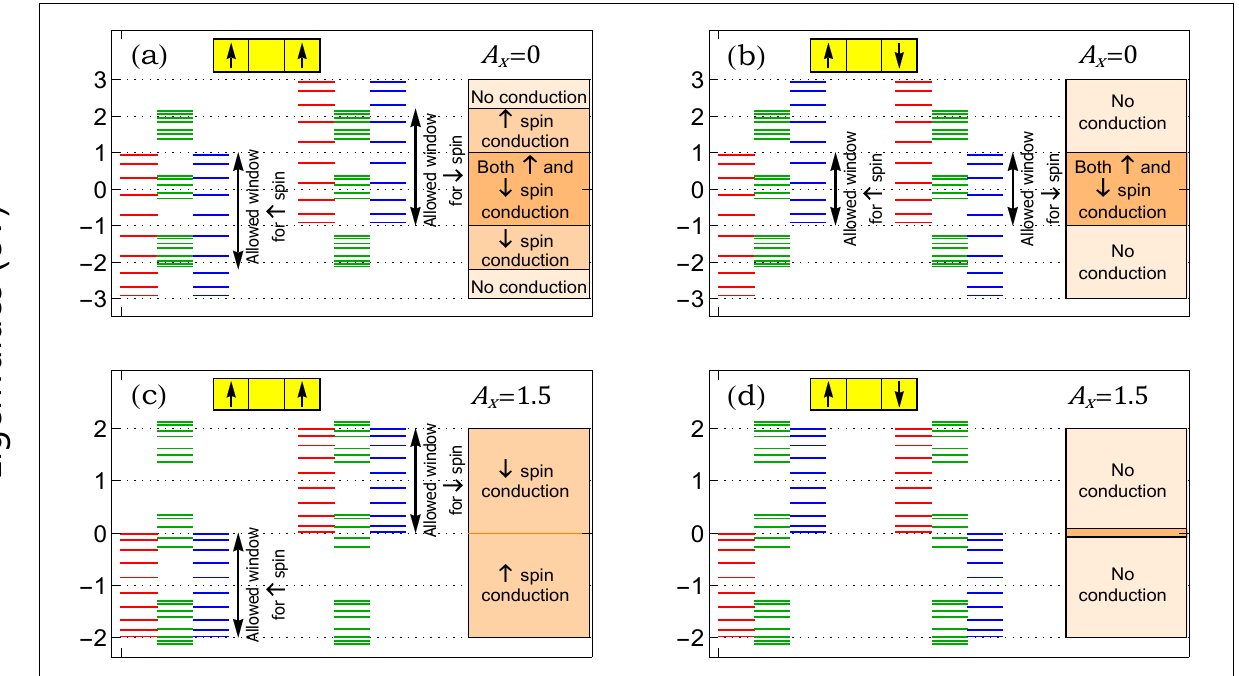
Figure 3. ( a – d ) (Color Online). Energy levels of three different layers of the heterostructure, where the red, green, and blue energy bands are associated with the free layer, the NM spacer, and the fixed layer, respectively. Two different cases, irradiation-free and with irradiation, are shown. In each of the spectra, the left three colored bands are for the up spin electrons, while the other three are for the down spin electrons. On the right most side, the uniformly filled colored regions are used to illustrate through which energy zone an electron can transfer or not. The AAH phase φ ν is fixed to